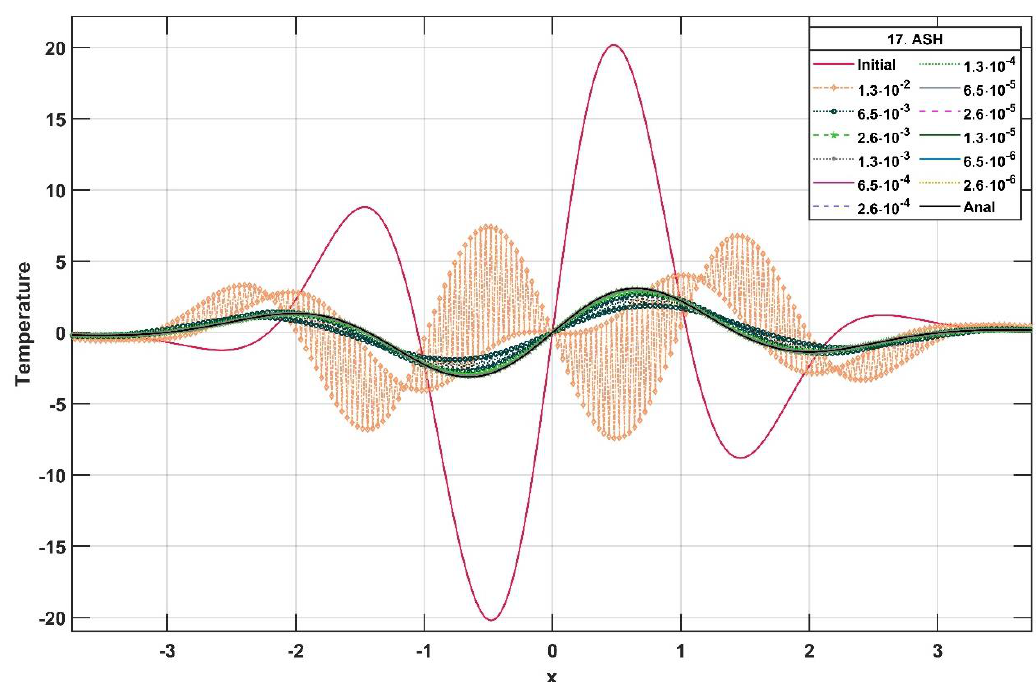
are for the initial and the analytically calculated temperatures, respectively.